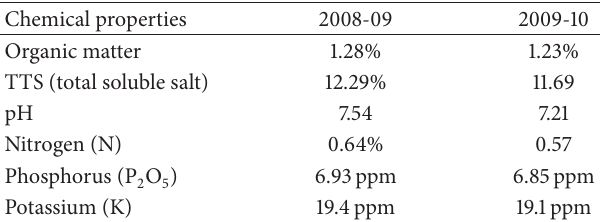
Table 1: Physical and chemical analysis of